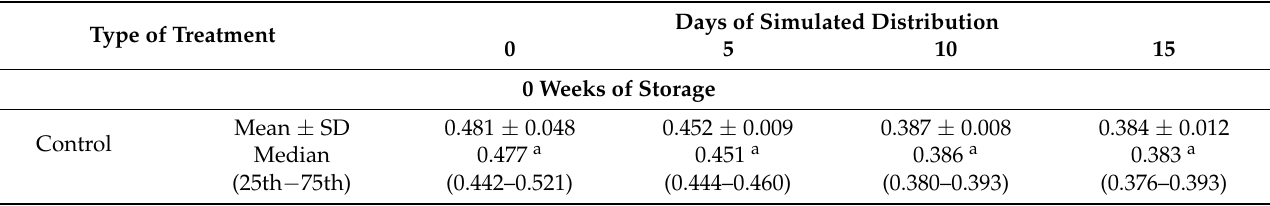
Table 4. The observed values of Titratable Acidity (TA) (%) for Idared apples after 8 weeks of simulated transportation, for the sub-groups subjected to various postharvest treatments, storage duration and duration of